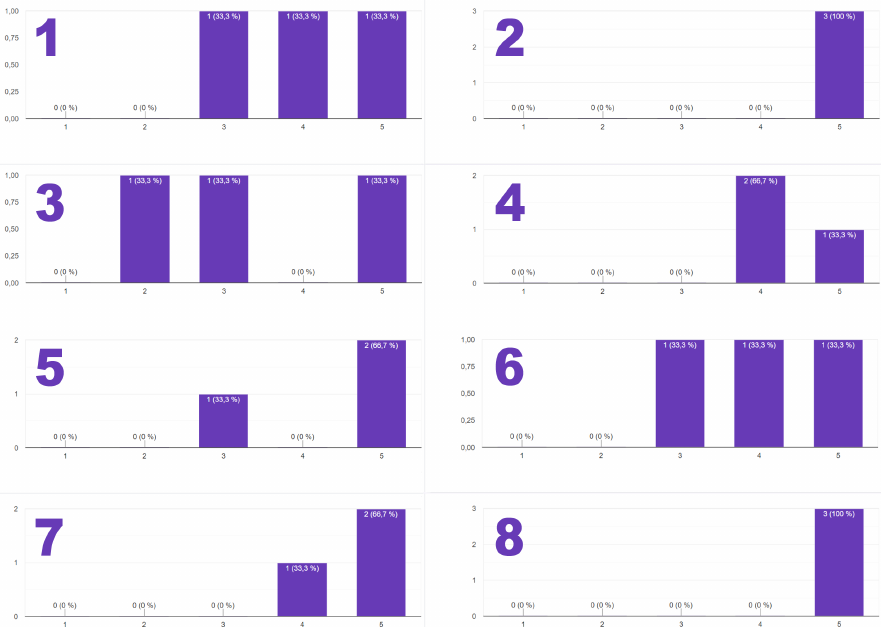
Figure 35. Success rate of the tasks: (1) Assembly (motors, parts, aluminium, etc.), (2) Android User Interface Application (MIT APP Inventor), (3) Semi-autonomous Vision-based Python Control, (4) Robotic Mission (pressing the button), (5) Robotic Mission (unscrew), (6) Robotic Mission (recover shield), (7) Robotic Mission (recover radioactive source), (8) Overall Level of Satisfaction.